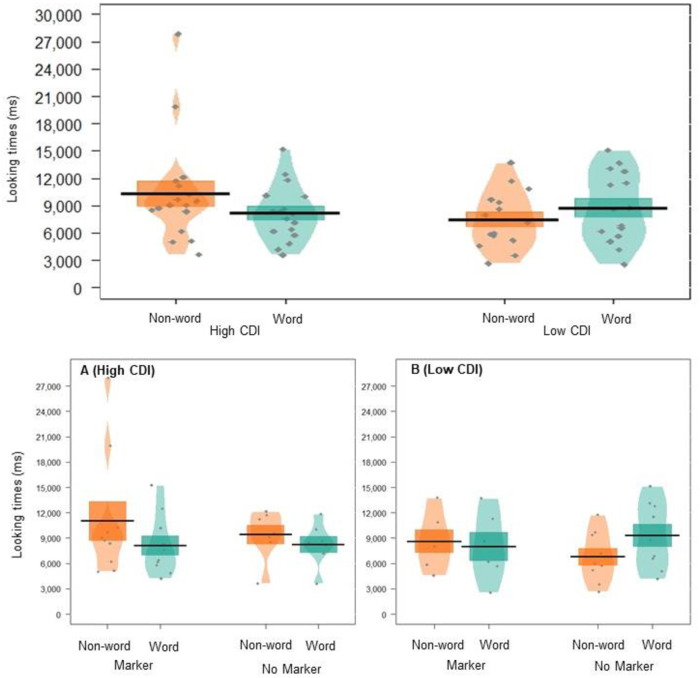
Pirate plot depicting the (raw) mean looking times to words and non-words for the participants in experiment 2.The top panel displays this data for High and Low CDI groups. The bottom panel breaks this down into each markers condition, with the High CDI group in panel A, and the Low CDI group in panel B. Black lines indicate the mean, and the coloured blocks indicate SE. Coloured shapes show the distribution of looking times for each group, with individual data points in grey.